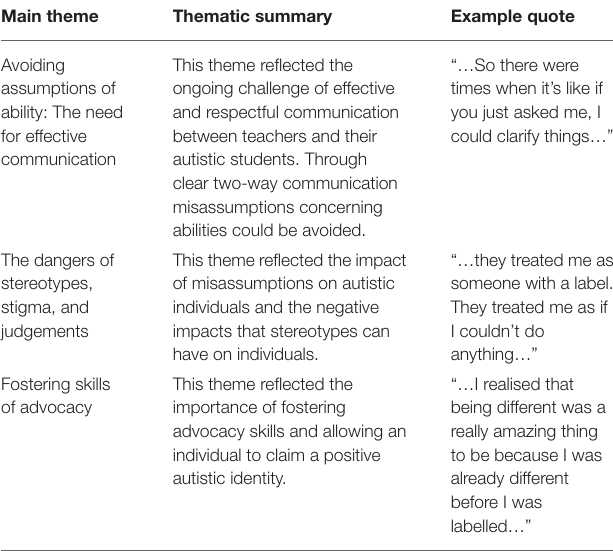
TABLE 2 | Thematic summary and